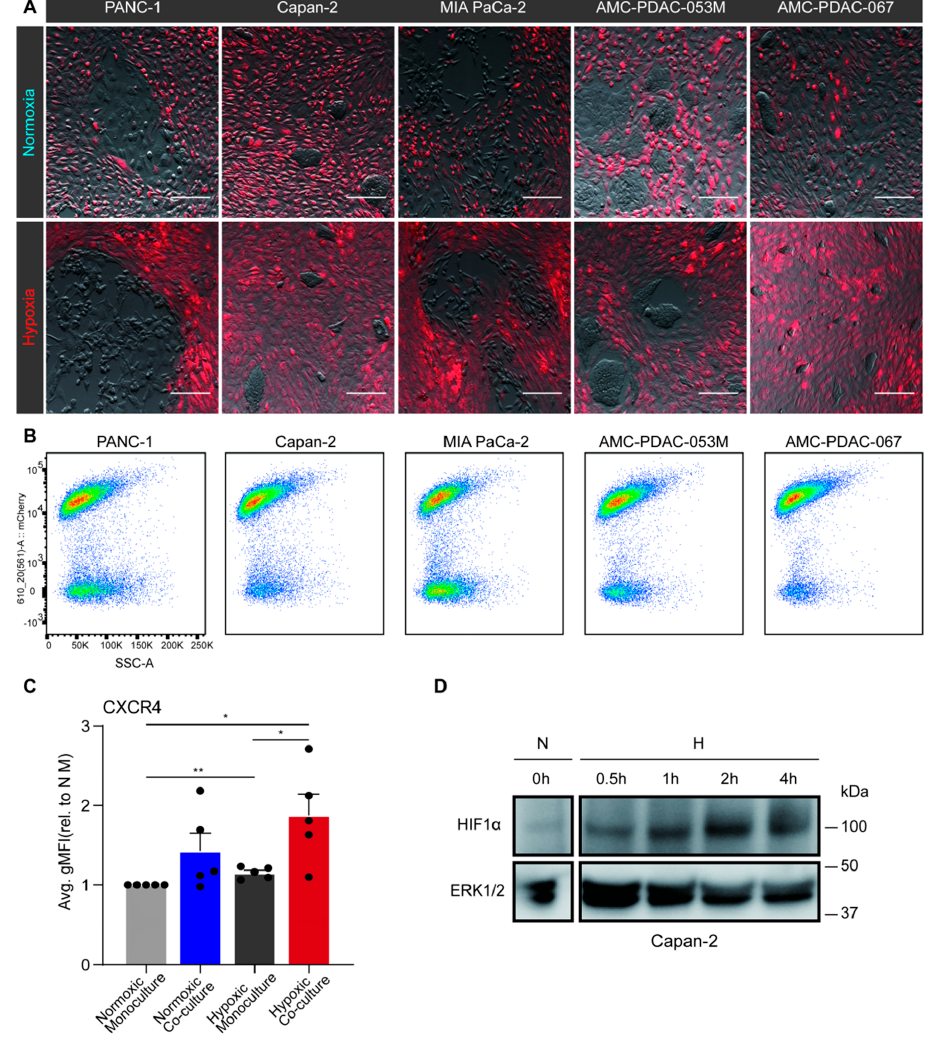
Figure 2. Hypoxia-activated pancreatic stellate cells (PSCs) promote epithelial-to-mesenchymal transition (EMT) in pancreatic ductal adenocarcinoma (PDAC) cells. ( A ) PS1 stellate cells were transduced with an mCherry fluorescent construct (red). Next, untransduced PANC-1, Capan-2, MIA PaCa-2, AMC-PDAC-053M, AMC-PDAC-067 PDAC cells were either co-cultured with mCherry- labeled PS1 or monocultured for 96 h under normoxia or hypoxia. Images are shown of co-cultured cells after 96-h normoxia (upper row) or hypoxia (lower row; brightness and contrast of the images were adjusted). Scale bar: 50 µm. ( B ) Flow cytometry cytoplot examples of the co-cultures as shown in panel A. Populations in the cytoplots indicate mCherry-positive PS1 cells and negative PDAC cells (mCherry signal is on Y -axis). Cells were dissociated from the coculture prior to fluorescence- activated cell sorting, separating the PS1 cells and PDAC cells. ( C ) CXCR4 expression of PDAC cells was determined by flow cytometry. Values represent the average gMFI ± S.E.M. of all PDAC cell lines and were normalized to normoxic monoculture group (* p < 0.05, ** p < 0.01). Each dot refers to a cell line (PANC-1, Capan-2, MIA PaCa-2, AMC-PDAC-053M, AMC-PDAC-067). ( D ) Capan-2 cells were incubated under hypoxic conditions for indicated times with normoxic incubation as a control. Cells were processed for Western blotting, using antibodies against HIF1 α . ERK1/2 was used as loading control.